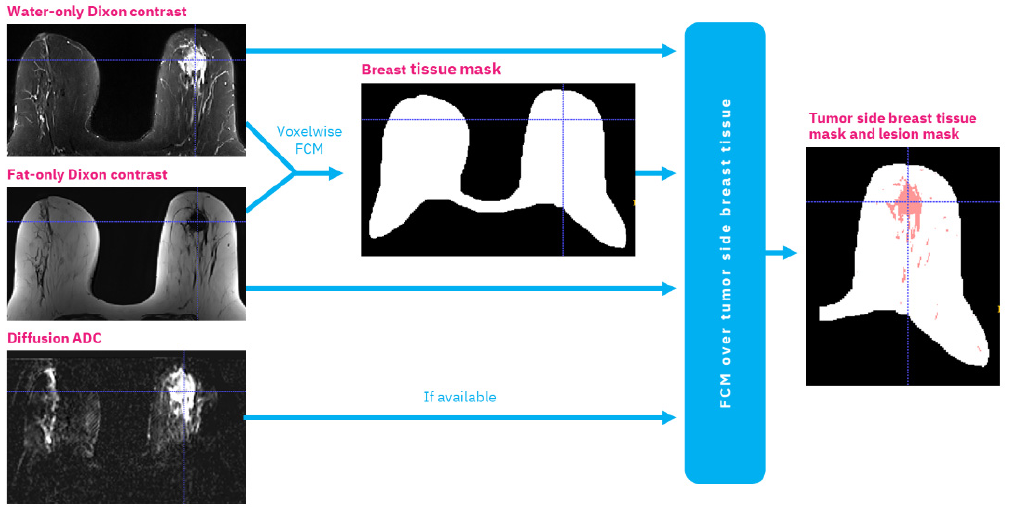
Figure A1. Breast tissue segmentation concept in the Dixon-ADC component. The first step with voxel-wise FCM (fuzzy C-means) segments the whole MRI volume to detect voxels, which belong to breast tissue. This is done with water-only and fat-only Dixon volumes. Then voxels that belong to the tumor side of the mask are again clustered with FCM using the same Dixon volumes, as well as diffusion ADC volume if it is available from the patient. The clusters with the biggest overlap on high-intensity areas on ADC and water volumes are selected as lesion regions.